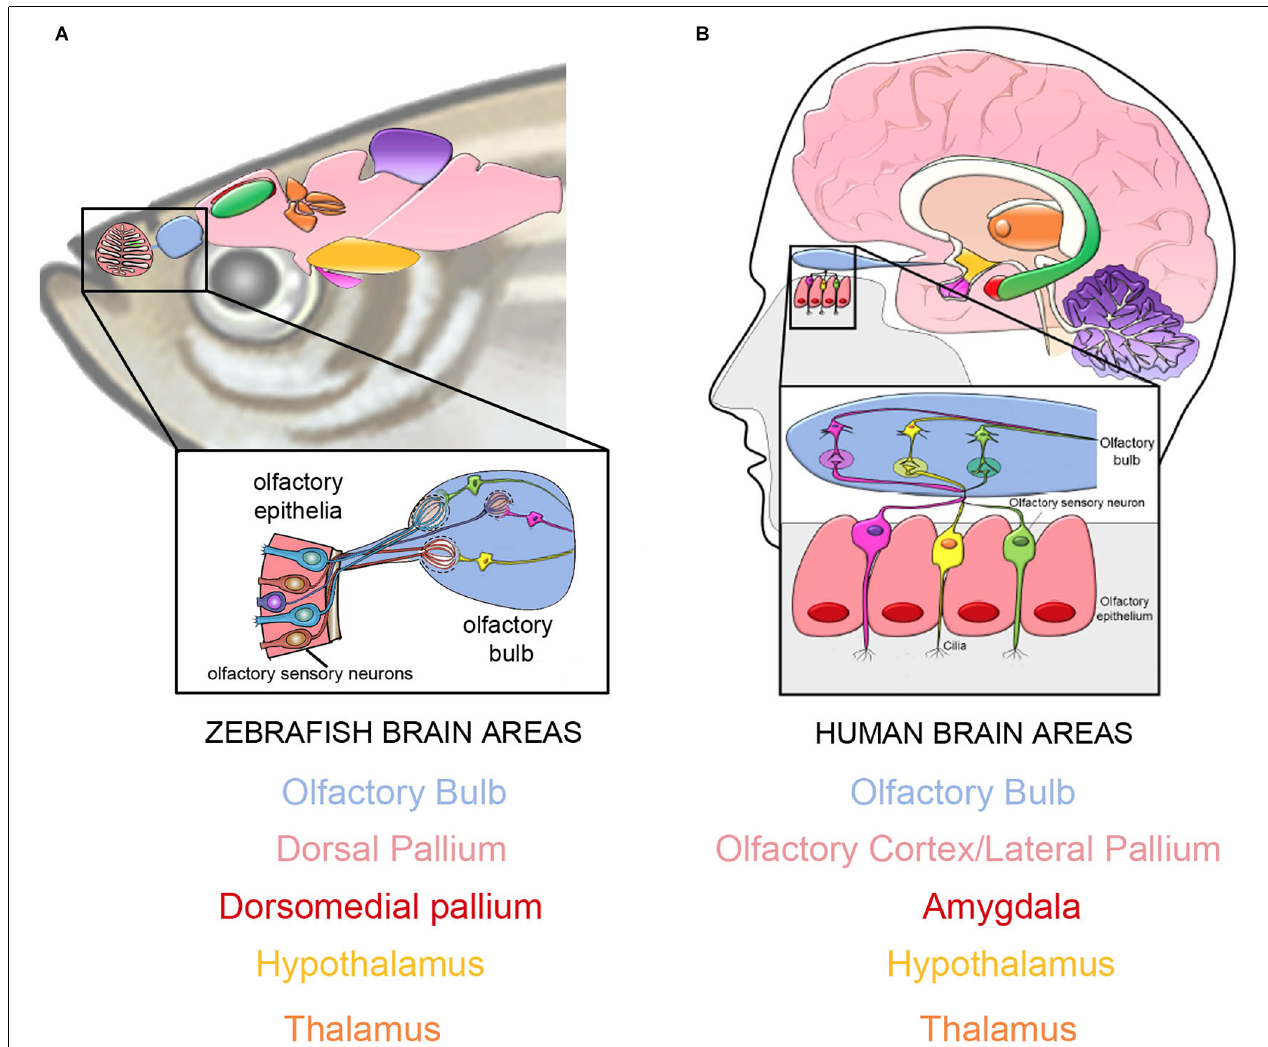
FIGURE 1 | The connections from the peripheral olfactory epithelia to the olfactory bulbs are highly conserved in vertebrates. In both in teleost fish ( A , zebrafish: modified from—Calvo-Ochoa and Byrd-Jacobs, 2019) and humans (B) the OSNs relay information to the olfactory bulbs (blue) continuing to the dorsal pallium in fishes (A) , and the olfactory cortex/lateral pallium (B) in mammals, thus bypassing the thalamus (orange). Both species have projections from the olfactory bulbs (blue) to the amygdala (red, B ) and its proposed equivalent in teleosts, the dorsomedial pallium (red, A